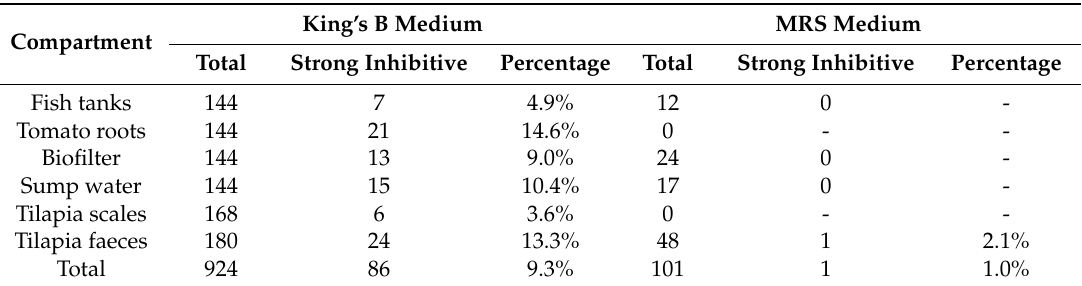
Table 1. Number of bacterial isolates obtained from the model aquaponic system, number of strains presenting a strong inhibition effect against the plant pathogen Pythium ultimum (>55% mycelial growth inhibition), and percentage of positive strains for both growth media.